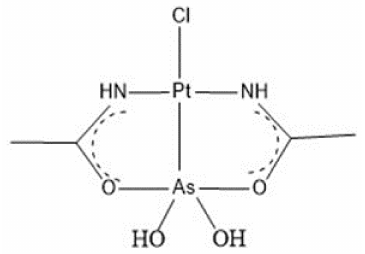
Figure 1. Schematic representation of AP-1.